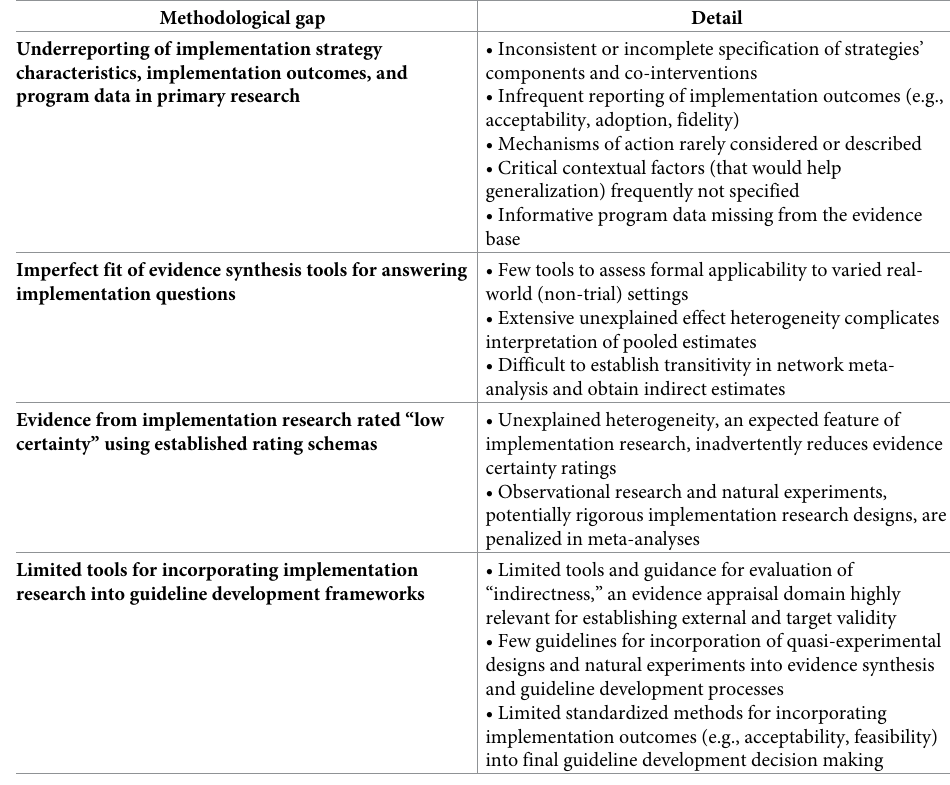
Table 1. Methodological gaps in evidence synthesis and guideline development for HIV implementation